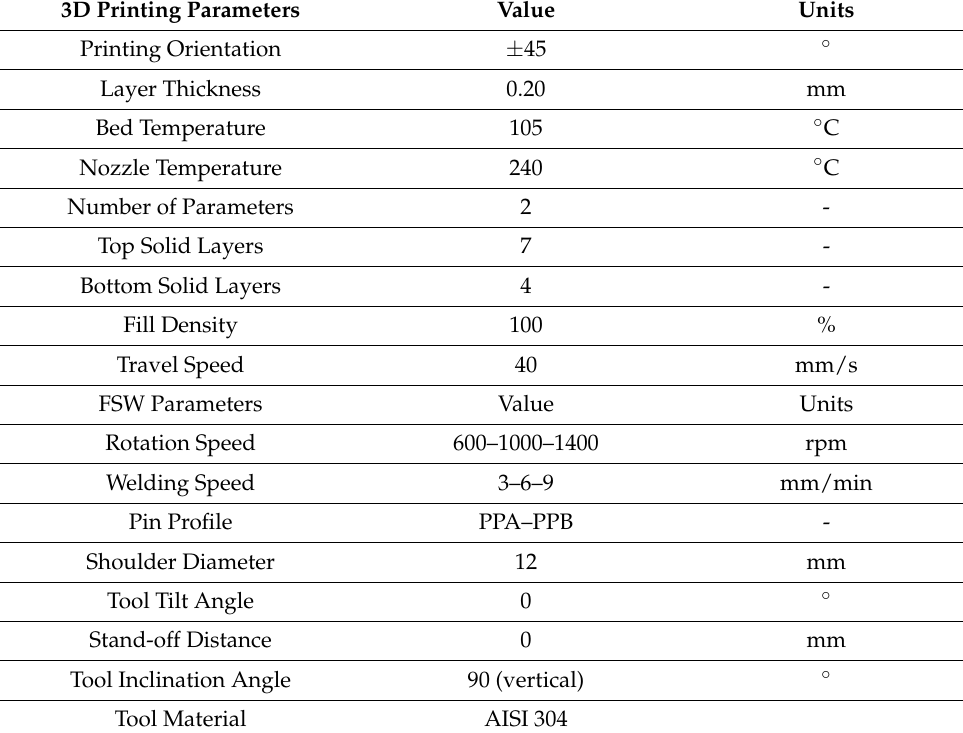
Table 1. 3D printing and FSW parameters used in this